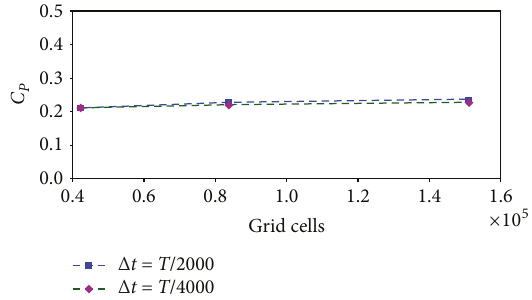
Figure 3: The power coe ffi cient of a semiactive fl apping wing with di ff erent meshes and iteration time steps.